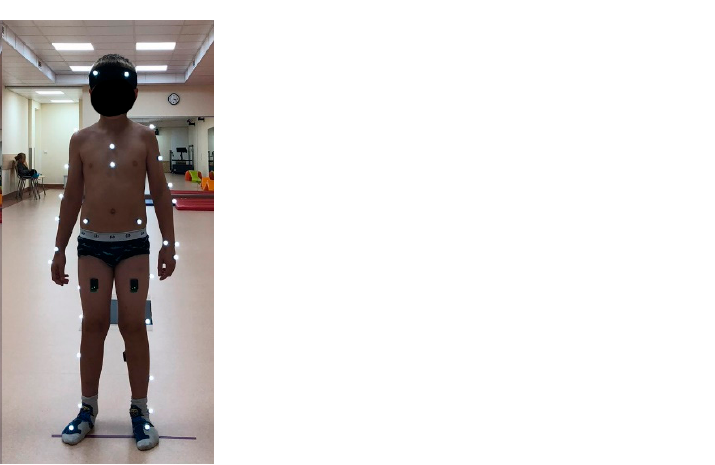
Figure 1. Children gait measurement setup with 39 Vicon reflective markers (indicated by white dots) and 10 EMG sensors attached by black disposable stickers at both lower legs. Start and end of the 7 m trail are marked by sticky tape lines. Children walked barefoot during measurements. The children wore socks and wore light clothing outside of the experiment.